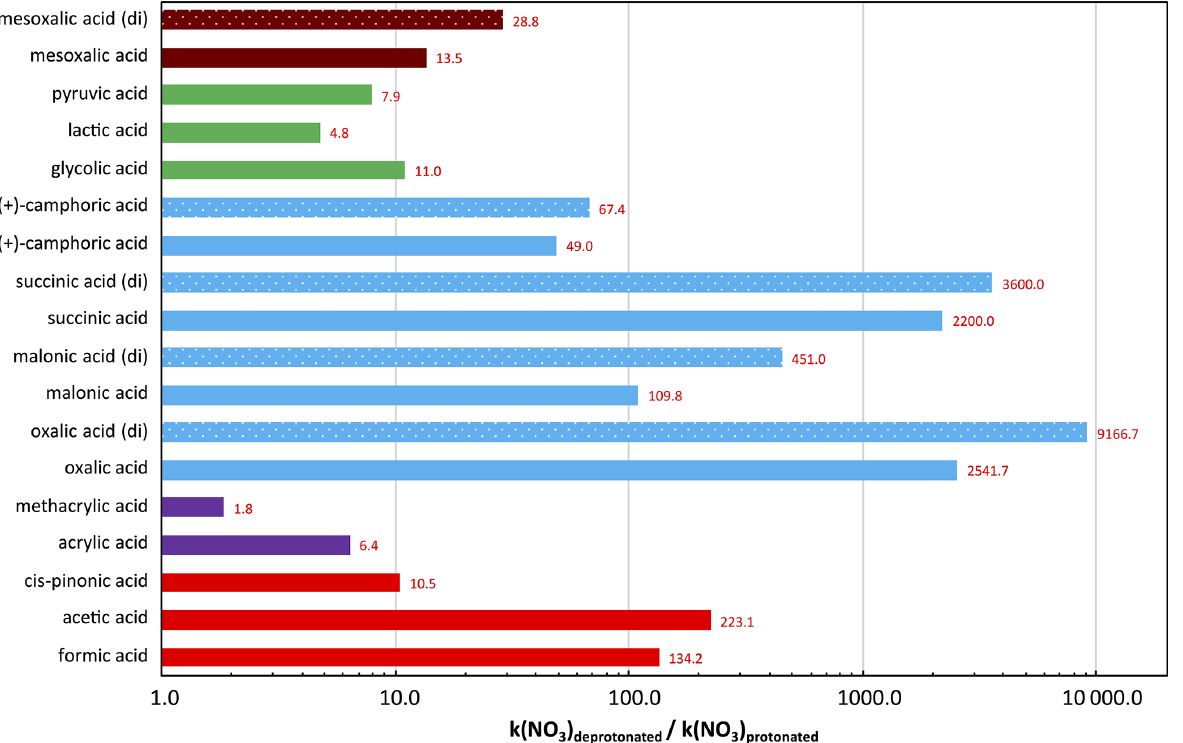
Figure 16. Calculated reactivity ratios κ R ( NO 3 ) of different carboxylic acids. The κ R ( NO 3 ) ratio of the dianion and protonated diacid is indicated by the add-on, (di), behind the acid name. The applied aqueous-phase NO 3 reaction rate constants are provided in Table S6 in the Supplement. Different colors indicate different compound classes, such as unsubstituted saturated monoacids (red), unsubstituted unsaturated monoacids (purple), unsubstituted saturated diacids (blue), substituted saturated monoacids (green), and substituted saturated diacids (brown). The dotted bars mark the ratio of the